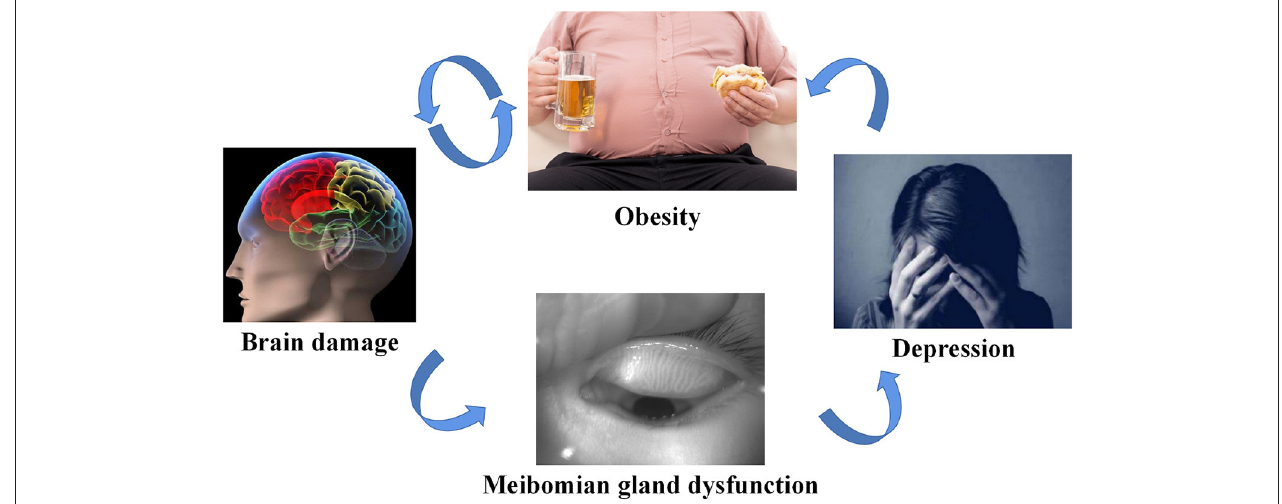
FIGURE 7 | Schematic diagram of the relationship between SO, brain dmage, MGD and depression. Compared with the HCs, fALFF values of the right cerebellum were significantly decreased in the PATs, which were more likely to suffer from anxiety and depression. (Anxiety and depression are not critical symptoms of MGD in SO population). SO, severe obesity; MGD, meibomian gland dysfunction; fALFF, fractional amplitude of low-frequency fluctuations; HCs, healthy controls; PATs, MGD patients in SO population.